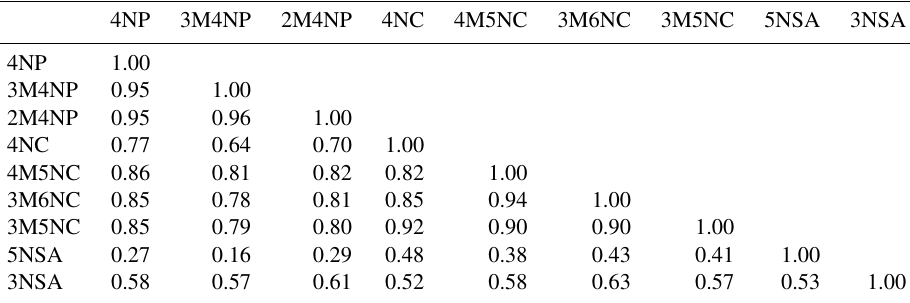
Table 3. Linear correlation coefficients ( r ) between individual nitrated phenols measured in PM 2 . 5 samples in five measurements. 4NP